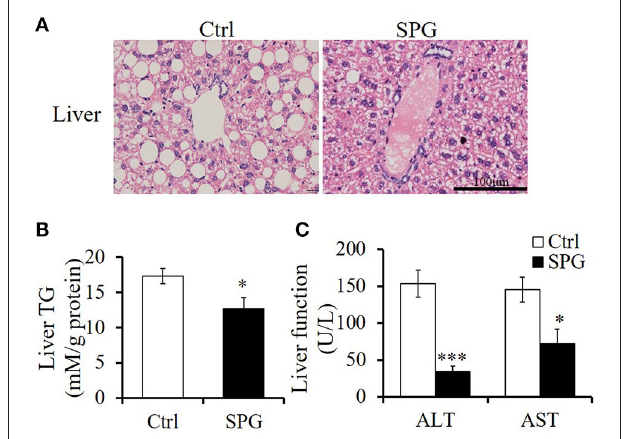
FIGURE 3 | Supaglutide improves hepatic steatosis of the DIO mice. (A) H&E staining of liver tissues. Scale bar: 100 µ m, 400 × . (B) Triglyceride content in liver tissue was determined and normalized to the total protein in the samples. (C) Aspartate aminotransferase (AST) and alanine aminotransferase (ALT) levels were measured in the blood serum of the mice. Significant difference between control and SPG is determined using unpaired Student’s t -test. All values are means ± SE ( n = 5 for each group). * p < 0.05; *** p <